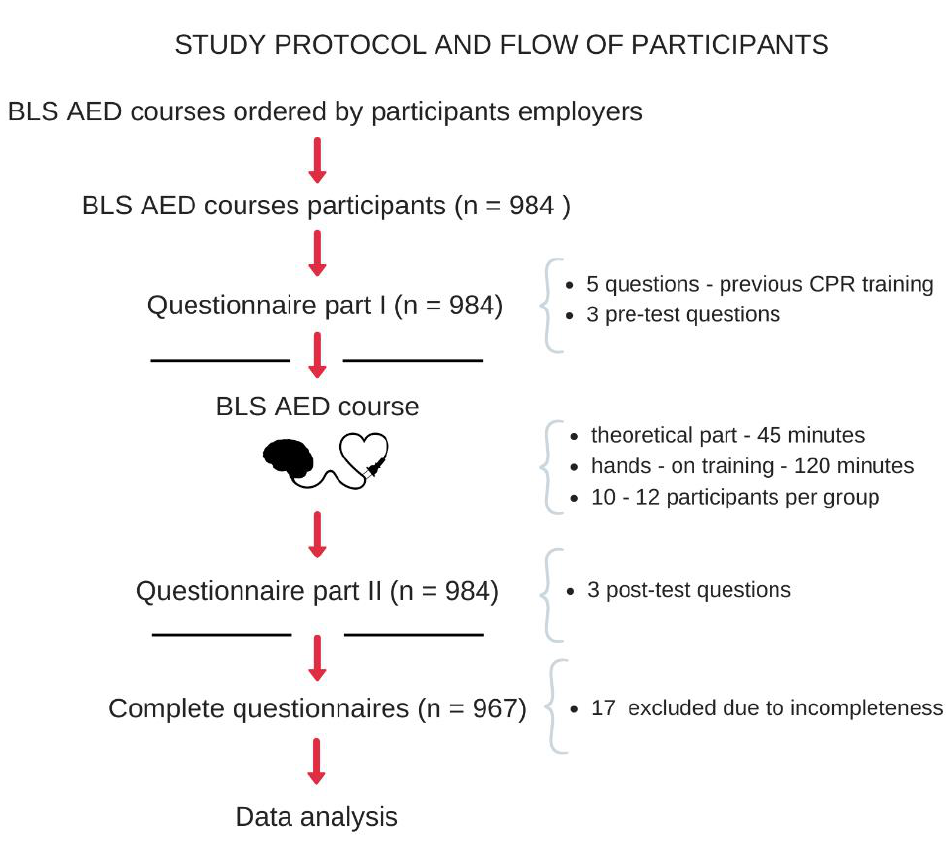
Figure 1. Study protocol and the flow of participants. BLS AED-effective basic life support and automated defibrillation; CPR-cardiopulmonary resuscitation .